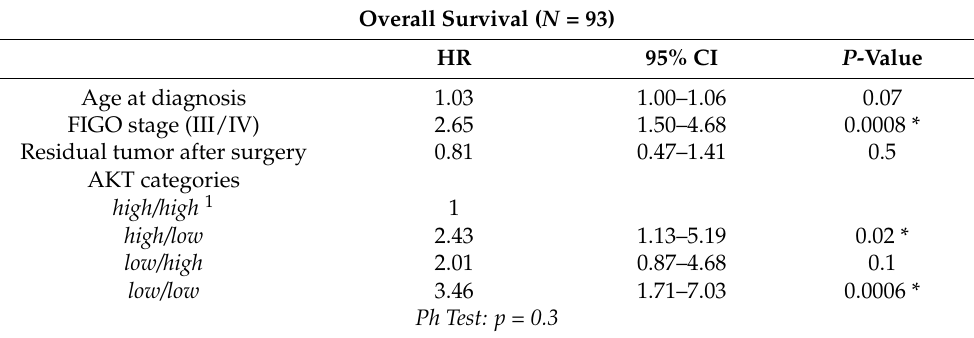
in Appendix A Table A2. Table 2. Prognostic factors for OS identified by multivariate Cox regression analysis.